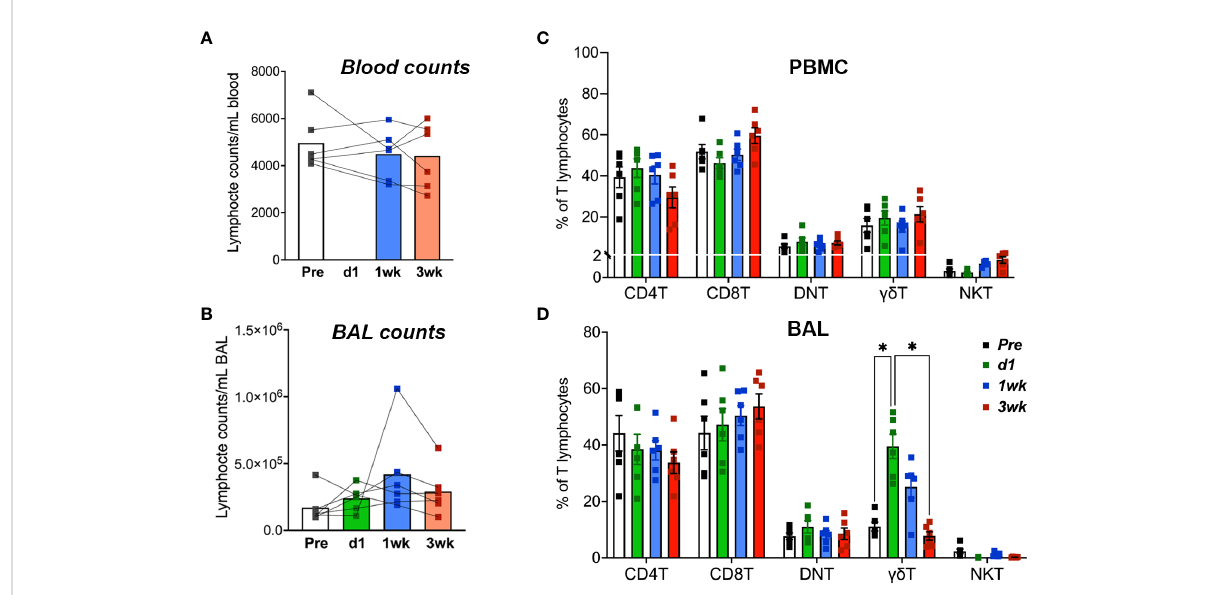
FIGURE 3 T Lymphocyte numbers in blood and BAL fl uid following aerosol BCG exposure. Absolute counts of (A) blood lymphocytes and (B) BAL lymphocytes at pre-BCG, day1 (d1)-, 1- and 3-week post-BCG inoculation of cynomolgus macaques. Frequencies of T lymphocyte subsets including CD4 T, CD8 T, DNT, gd T cells, and NKT cells determined by fl ow cytometry in (C) PBMC, and (D) BAL cells at the indicated time- points. Data shows mean and SEM. Time-points were compared using repeated measures two-way ANOVA with Tukey ’ s post hoc tests. Asterisks indicate signi fi cant differences in frequency of cell subsets between time-points (*p <